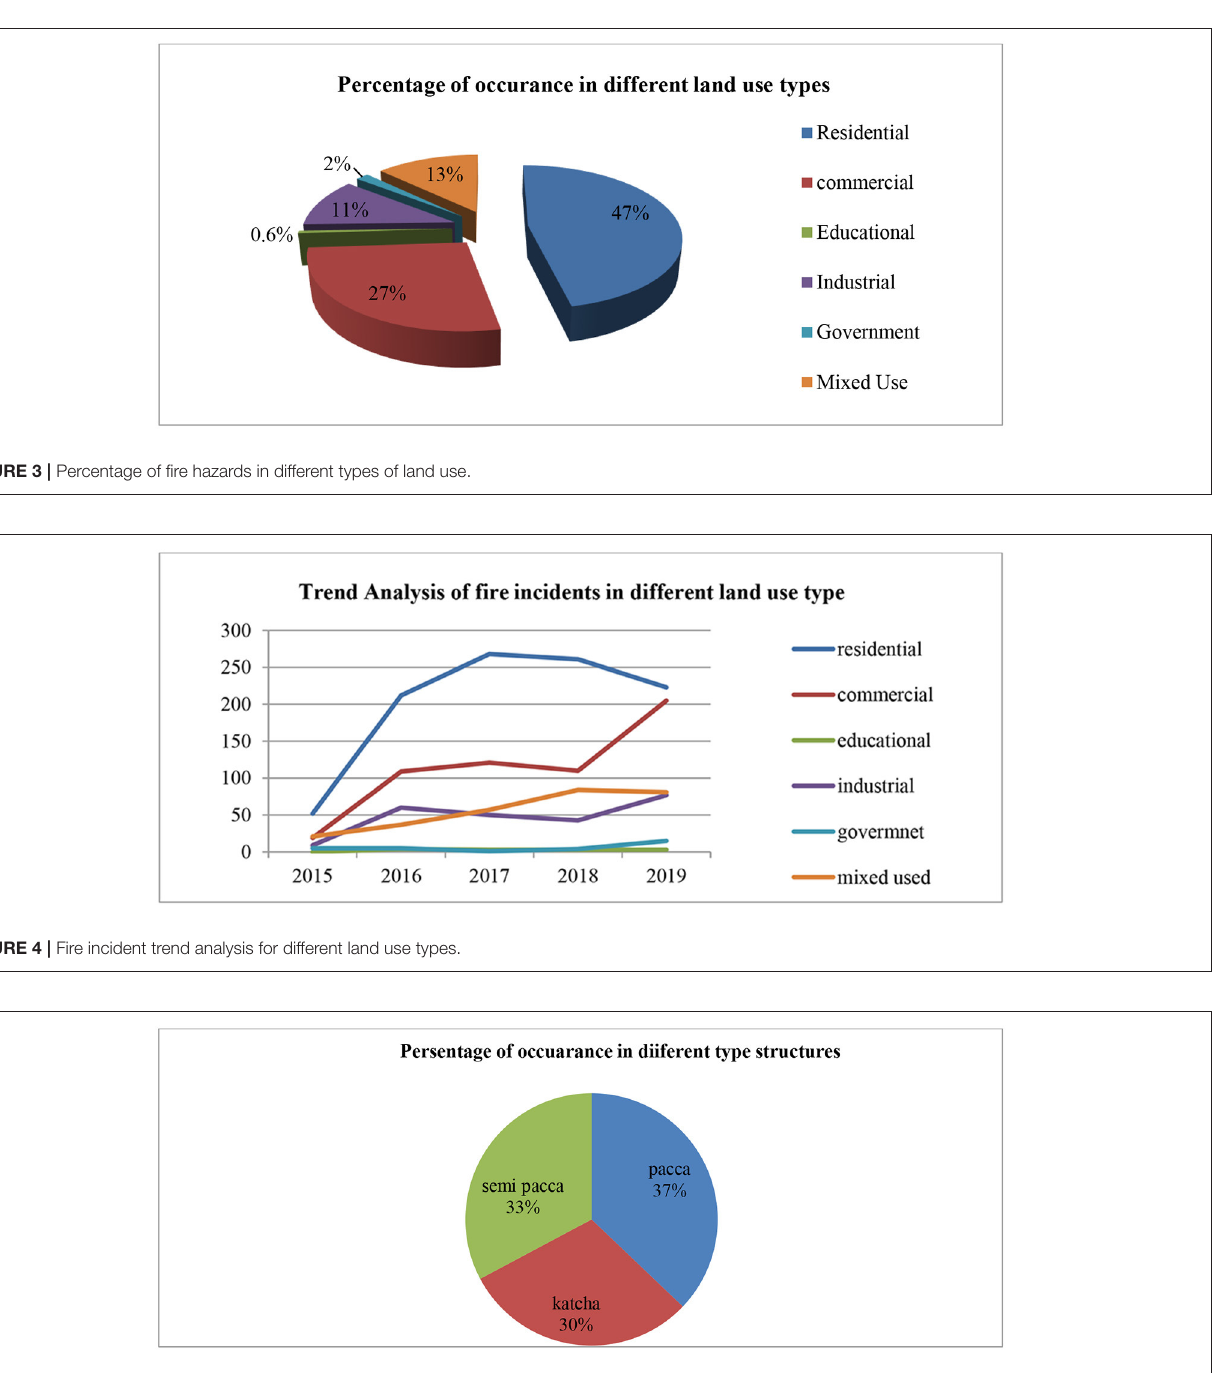
FIGURE 5 | Percentage of fire hazards in different types of